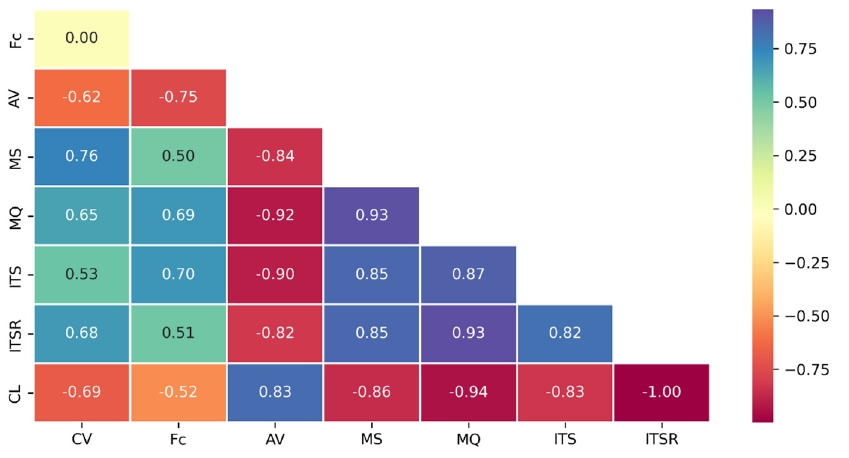
Figure 12. Pearson correlation matrix.